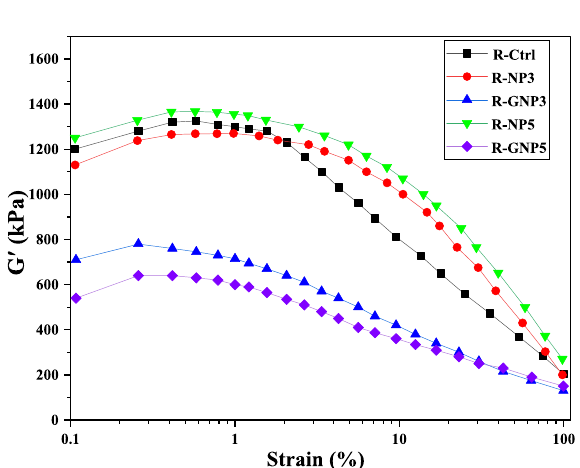
Figure 10. EDX-MAP Si elemental distribution images for: ( a ) R-NP, ( b ) R-GNP.